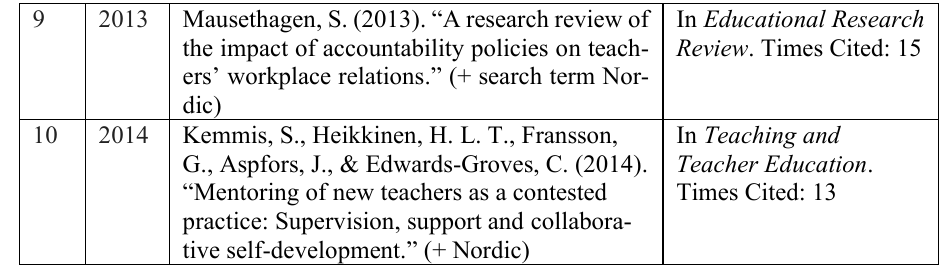
Nordic articles chosen for the